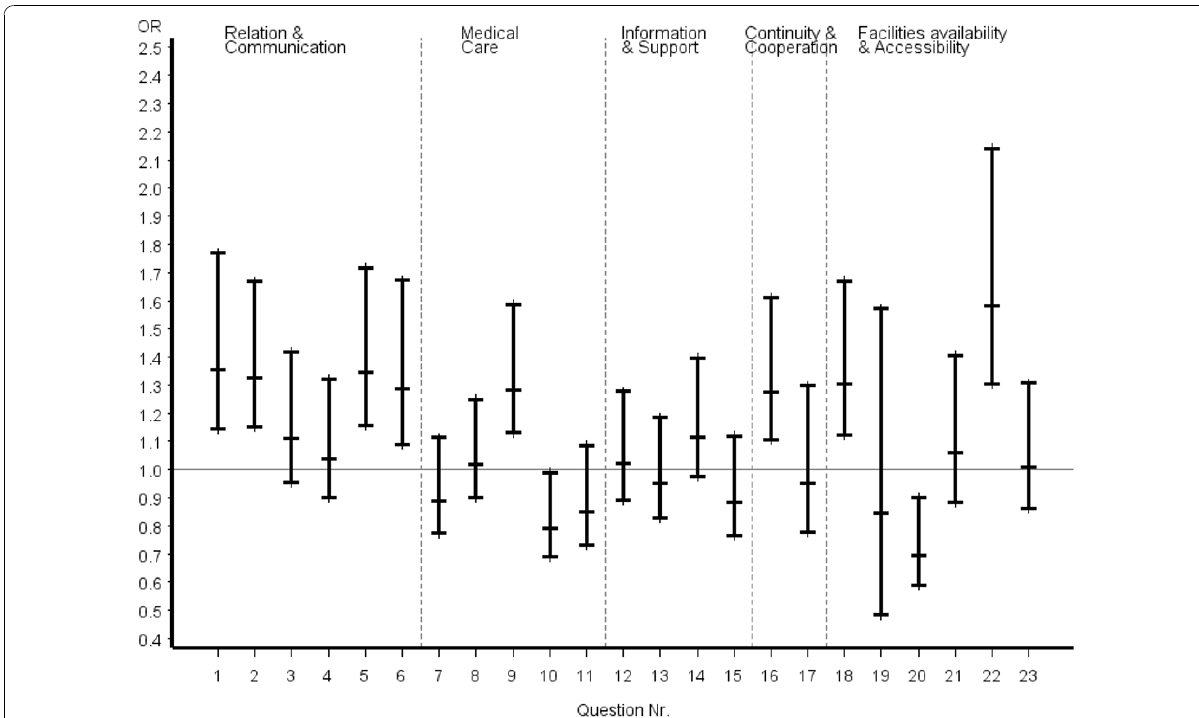
Figure 7 ..Europep questionnaire, odds ratios of most favourable answer option (certified CAM vs. COM) Stratified analysis of patients without higher education . Errorbars denote 95% confidence intervals of odds